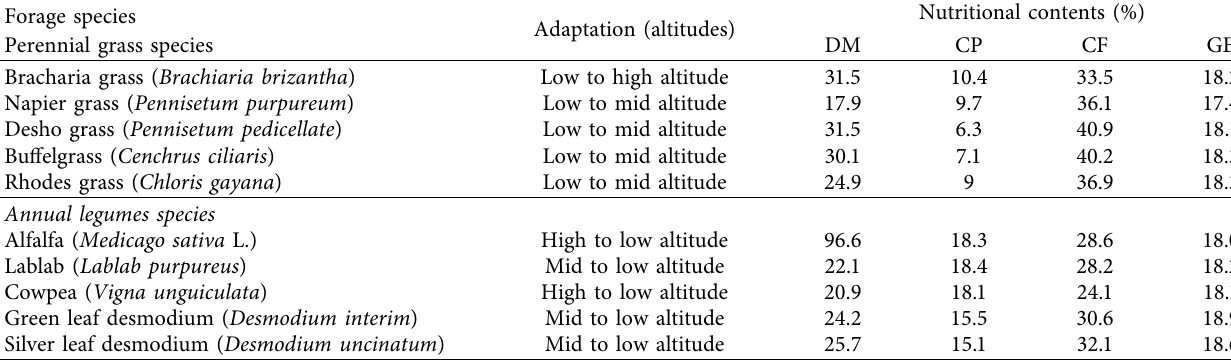
Table 1: List of forage species that are best for Ethiopia’s lowland agroecologies. Forage